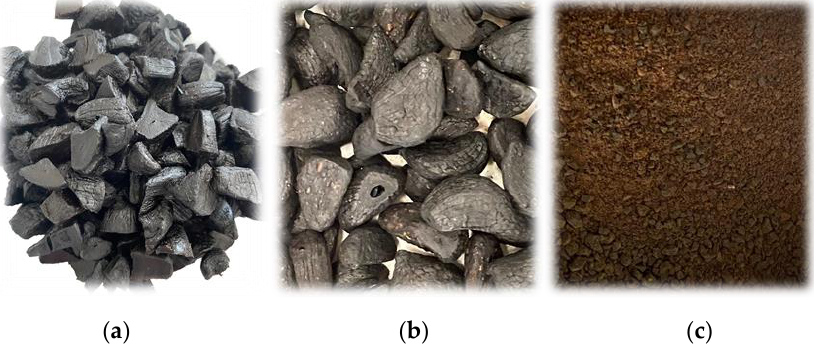
Figure 1. Fresh black garlic sample ( a ), black garlic after drying ( b ), and black garlic powder ( c